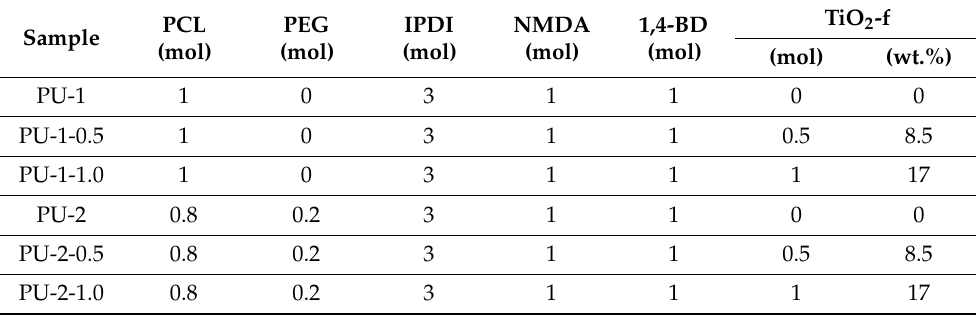
Table 1. Initial feed ratio of materials in the preparation of polyurethanes and